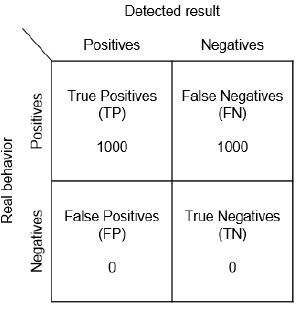
Figure 15. Impersonation attack confusion matrix.